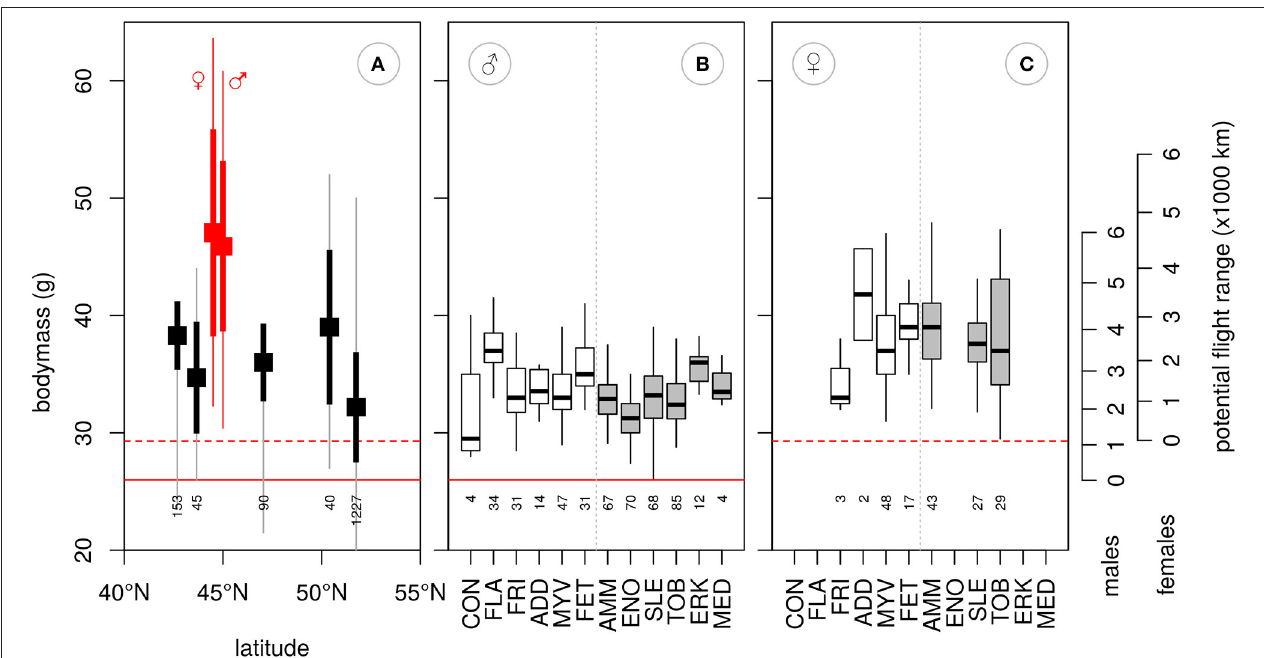
FIGURE 3 | Mean body mass obtained from (A) female and male Red-necked Phalaropes at autumn staging areas along the western (red, Bay of Fundy, Canada, Mercier, 1985), and unsexed birds from the eastern migration route (black, various sites in Kazakhstan, Gavrilov et al., 1983). Thick vertical lines represent ± SD, thin lines are ranges. Body mass of males (B) and females (C) at breeding sites. Western (white boxes) and eastern (gray boxes) populations are divided by a vertical gray dotted line. Whiskers extent to minimum and maximum values. Lean body mass of each sex, as inferred from our sample, are shown by the red horizontal solid (males) and dotted (females) lines. The right axis shows the potential maximum flight range for males and females (see main text). Breeding sites are ordered from West to East, and are abbreviated as follows: CON, Constable Pynt; Greenland, FLA, Flatey Island, Iceland; FRI, Fridland, Iceland; ADD, Að*aldalur, Iceland; MYV, Myvatn, Iceland; FET, Fetlar, Scotland; AMM, Ammarnäs, Sweden; ENO, Enontekiö, Finland; SLE, Slettnes, Norway; TOB, Tobseda, Russia; ERK, Erkuta, Russia; MED, Medusa Bay, Russia. Numbers below box-plots represent sample sizes.